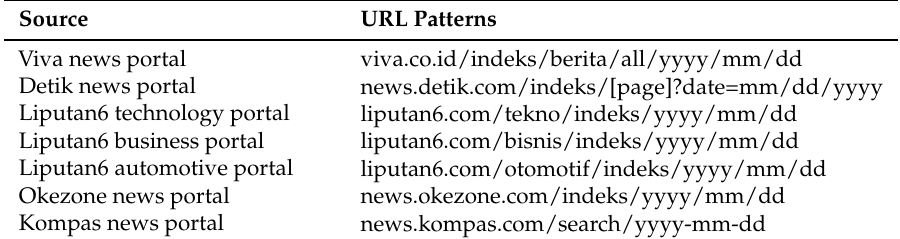
Table 1. URL patterns of the online news portals.